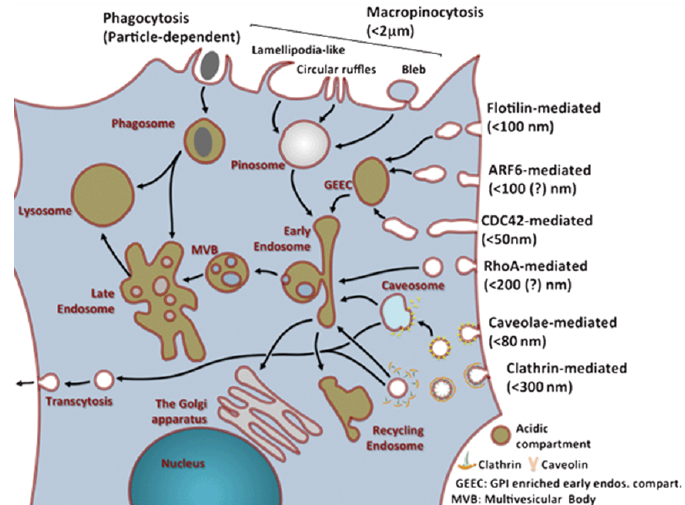
Figure 2. Overview of uptake and internal tra ffi cking via various endocytic pathways in a typical eukaryotic cell, with an estimated maximum uptake size for di ff erent pinocytosis mechanisms Figure 1. Scheme of the experimental procedure. (reproduced from Reference [24] with permission from The Royal Society of